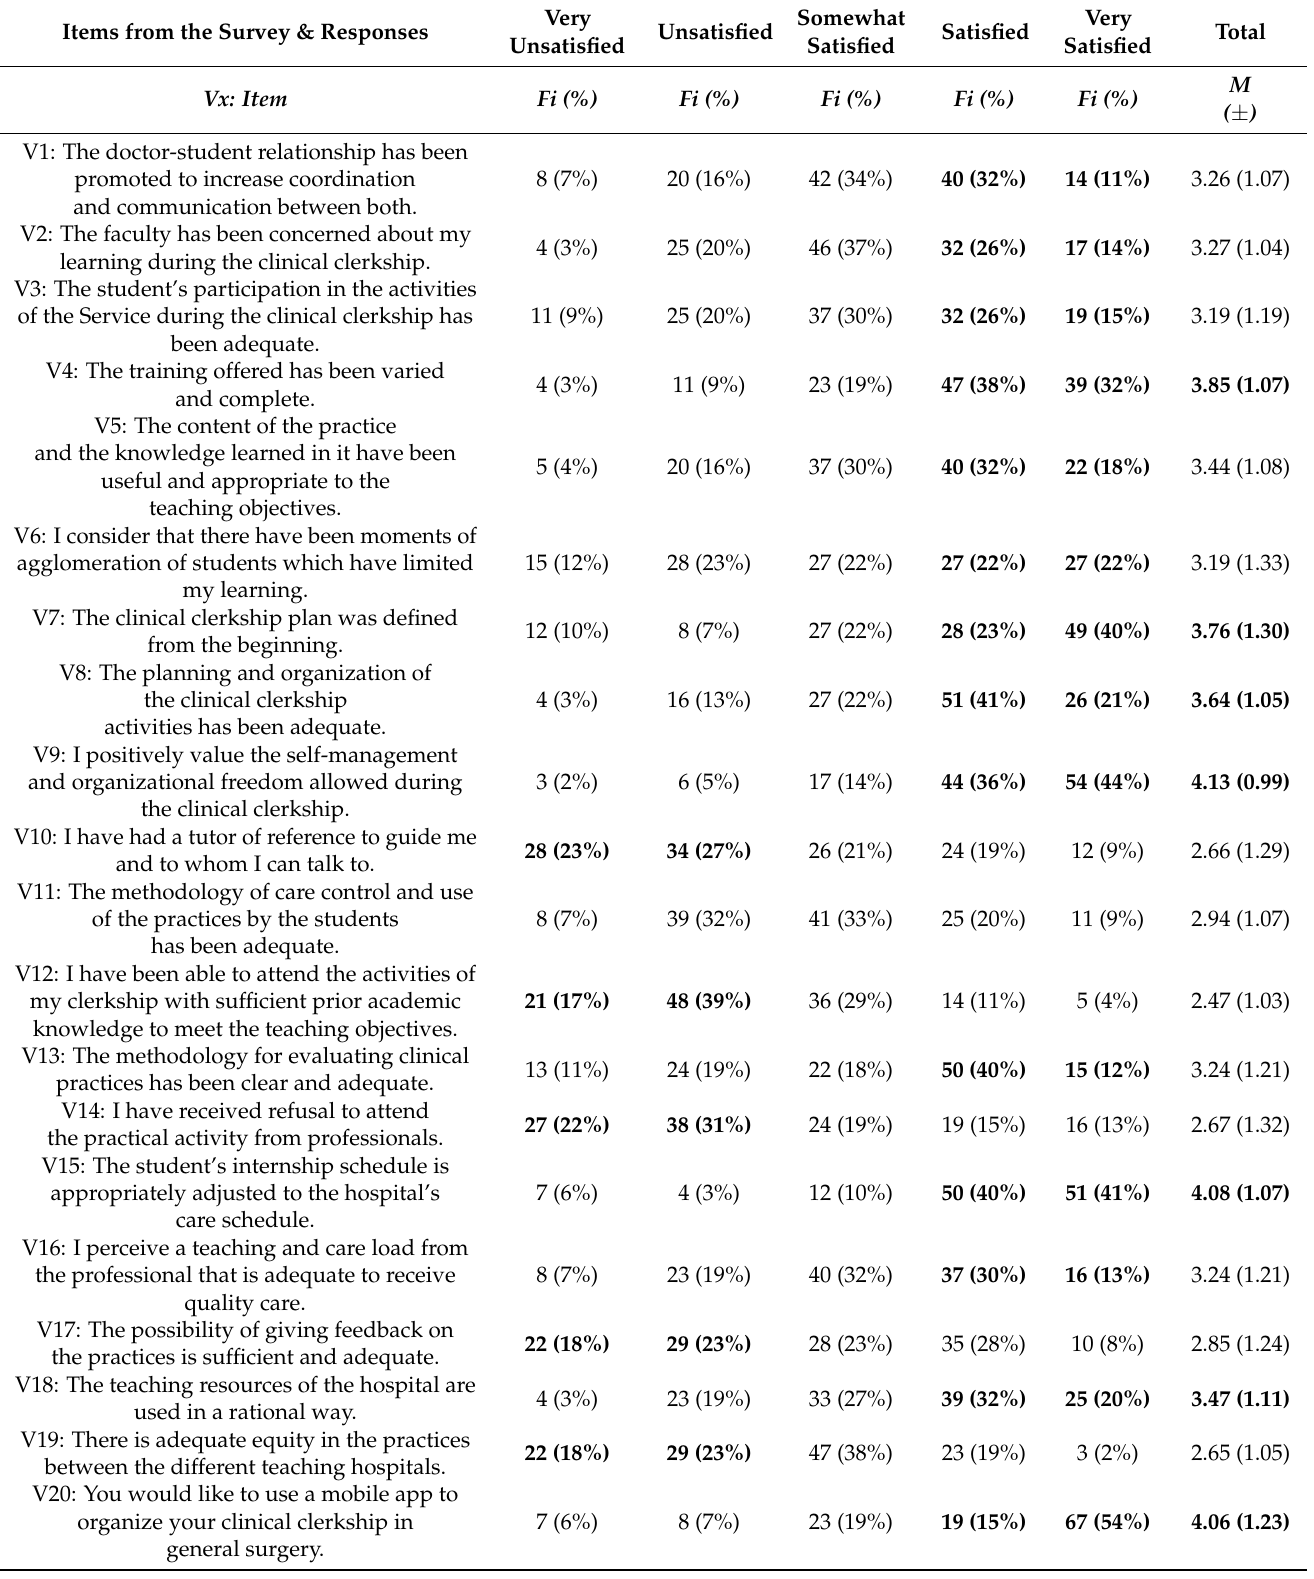
Table 2. Overall results from the four teaching